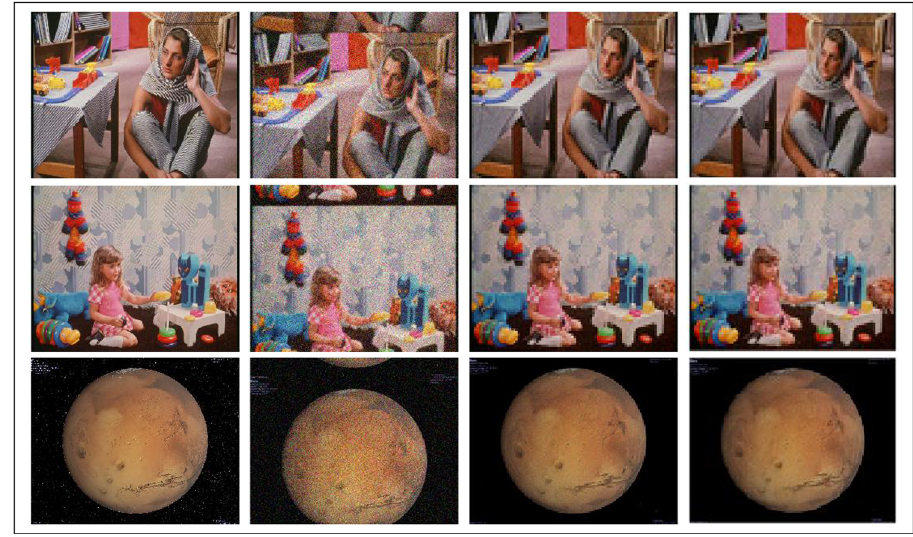
Figure 7: Restoration of test images, 720 576 × Barbara ( Top ) , followed by 720 576 × Girl, 1,280 1,024 × Mars. From the left: The original image, the blurred and noisy image with 10% noise, the restored image by CGD and DLPA ( right ) .